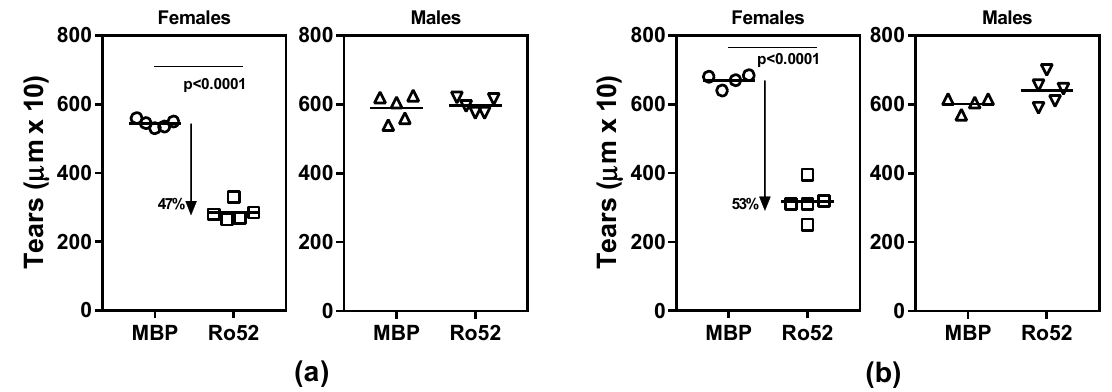
Figure 1. Loss of tear production in Ro52-immunized NZM2758 female mice. ( a ) Tear collection done 4 weeks post-immunization; ( b ) Tear collection done 10 weeks post-immunization in a different cohort of mice. In both panels, only female mice show a significant drop in mean tear volume.